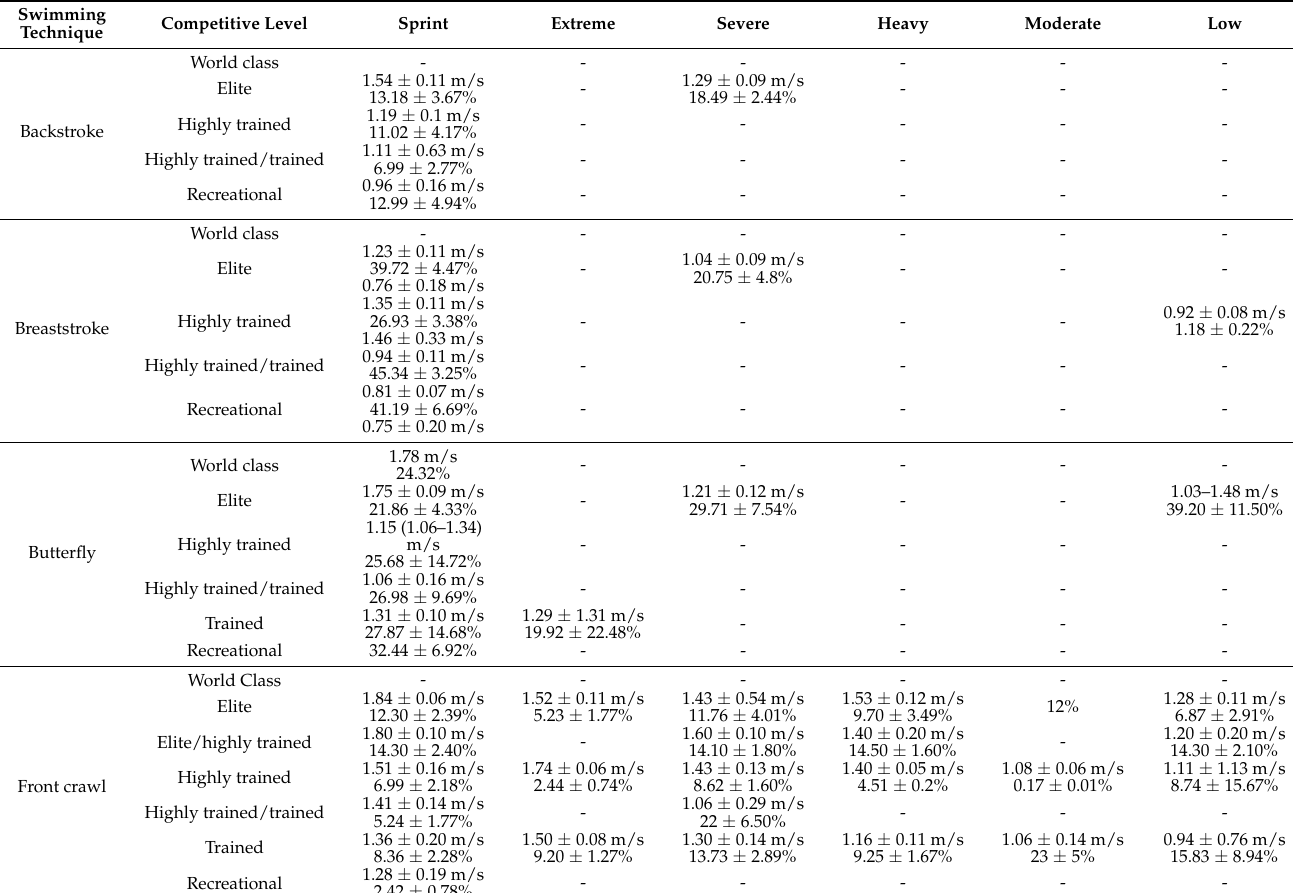
Table 3. Mean ± SD or median ± IQR mean velocity and IVV values obtained in the swimming trials included in the current